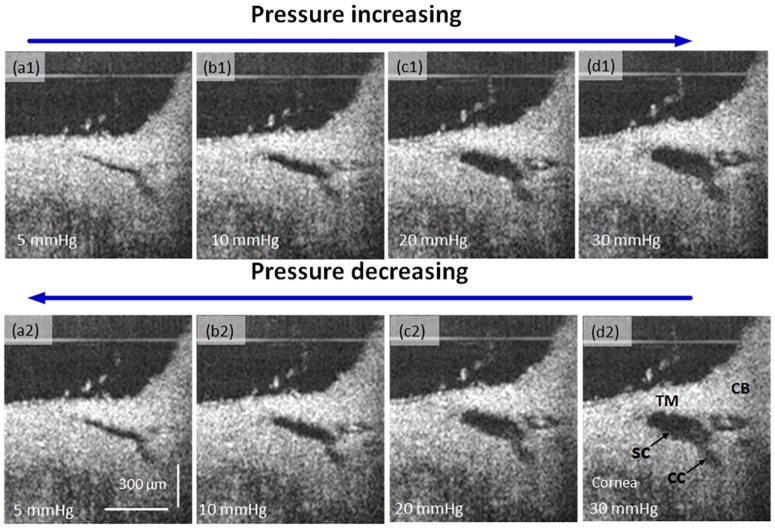
OCT cross-sectional images sequentially acquired at static progressively increasing perfusion pressures of 5, 10, 20 and 30 mmHg (top row) and then sequential acquisition in the reverse direction (bottom row).Ciliary Body (CB), TM Trabecular Meshwork (TM), Schlemm’s canal (SC), Collector Channel (CC).